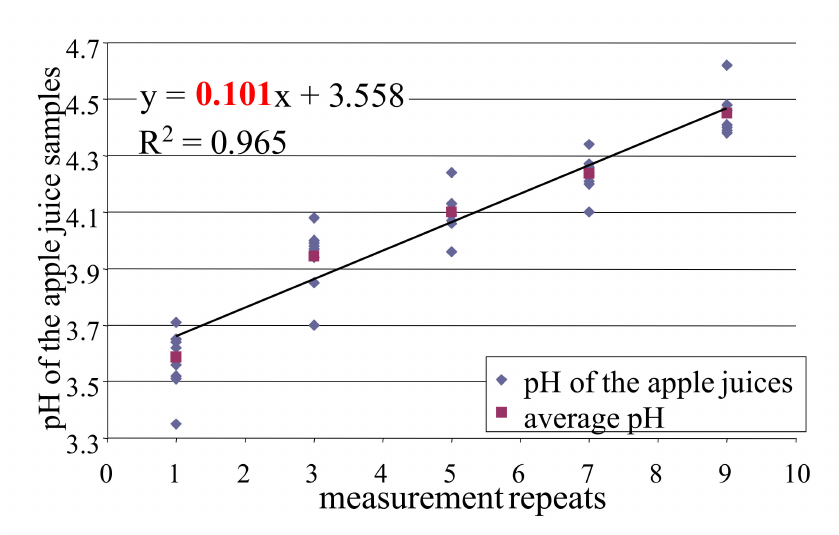
Figure 3. The increase of pH of apple juice samples versus electronic tongue measurement repeats.